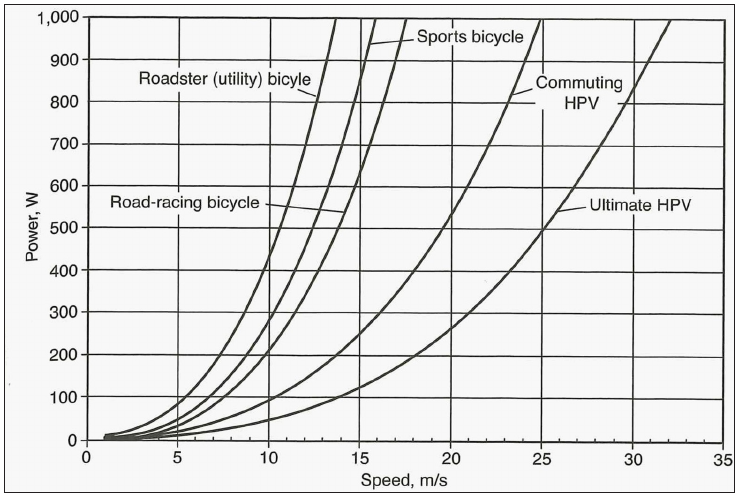
Figure 4: Speed in relation to power. Source: Wilson and Schmidt, 2020,